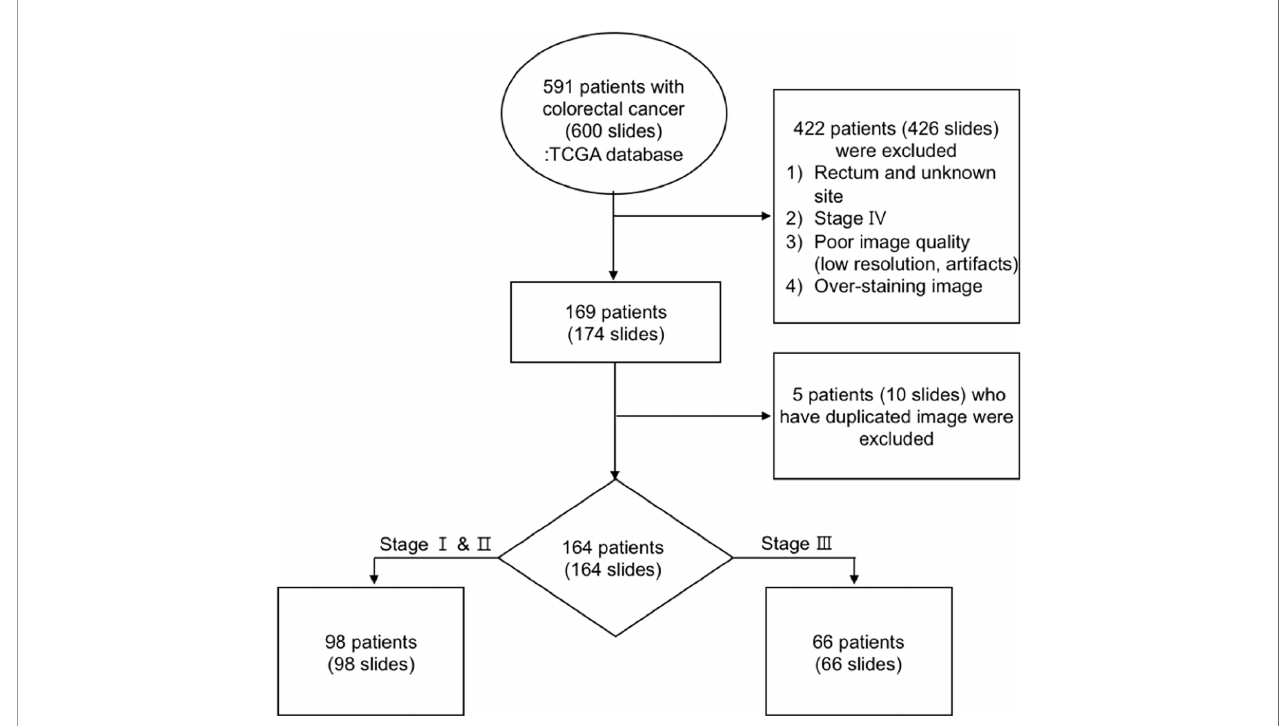
FIGURE 1 | Work fl ow of image data